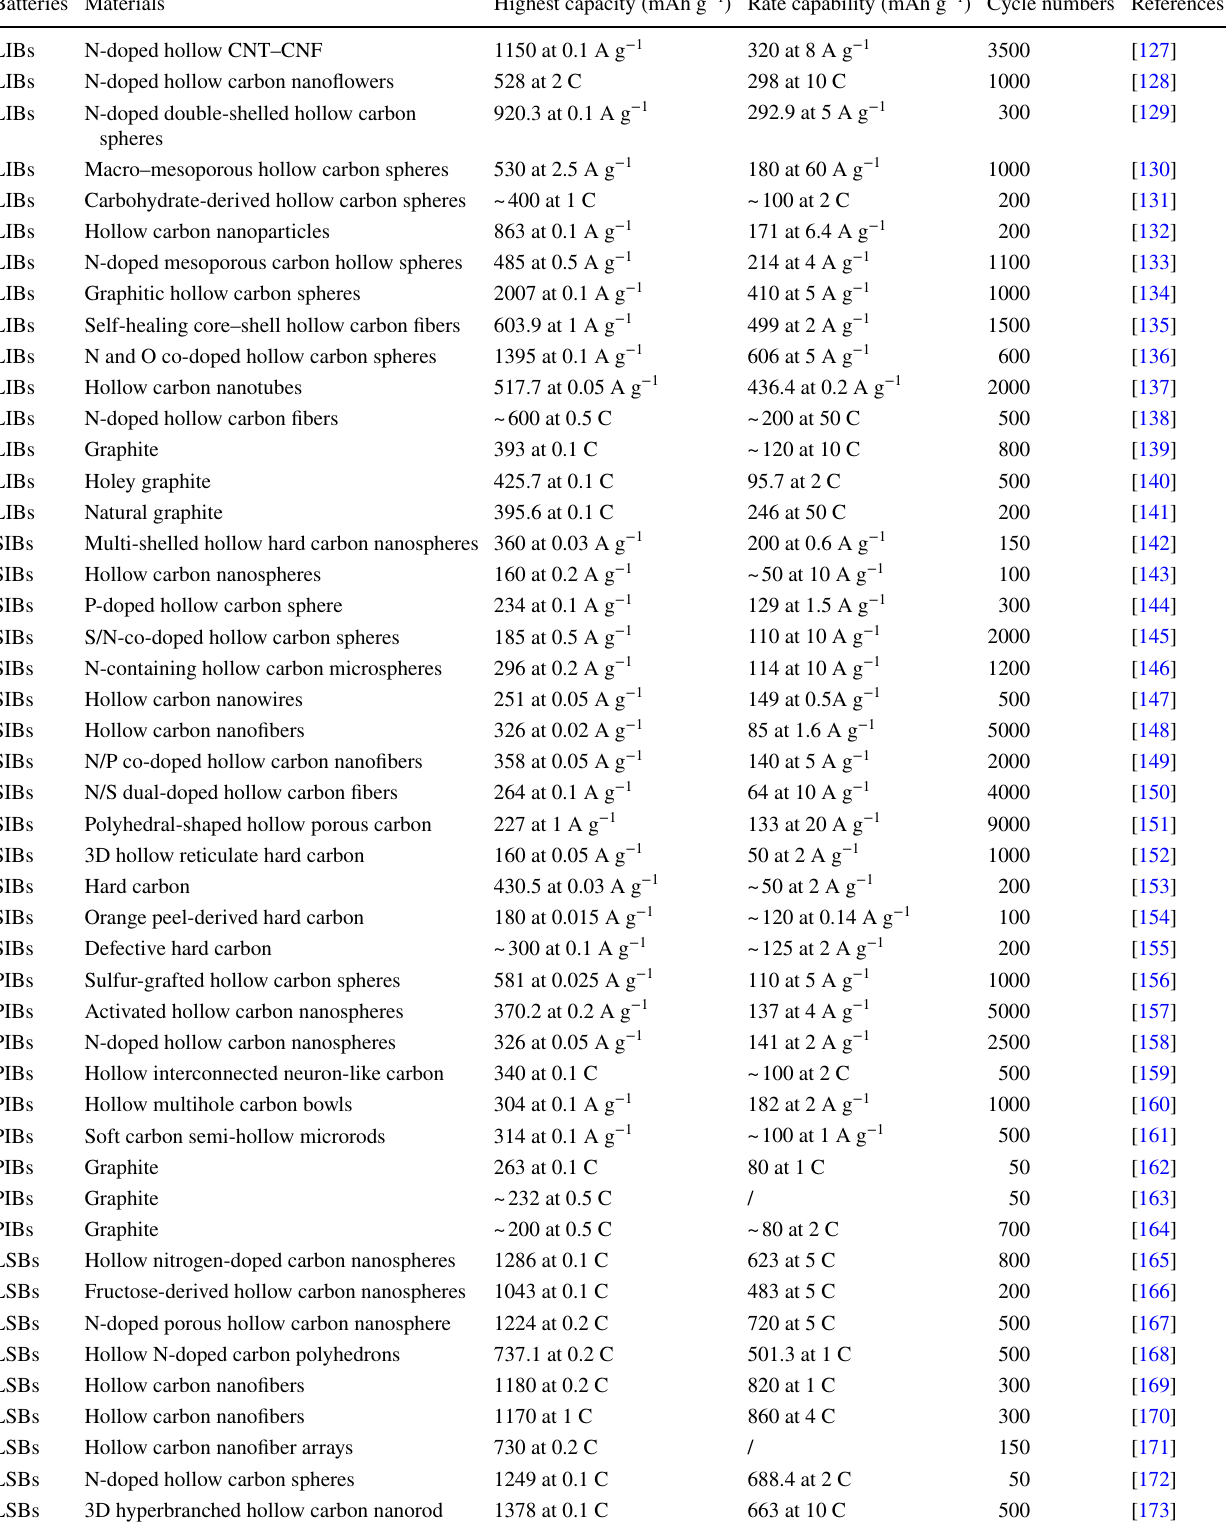
Table 1 Overall electrochemical performances of rechargeable batteries making use of nanohollow carbons, graphite, and hard carbon materials Batteries